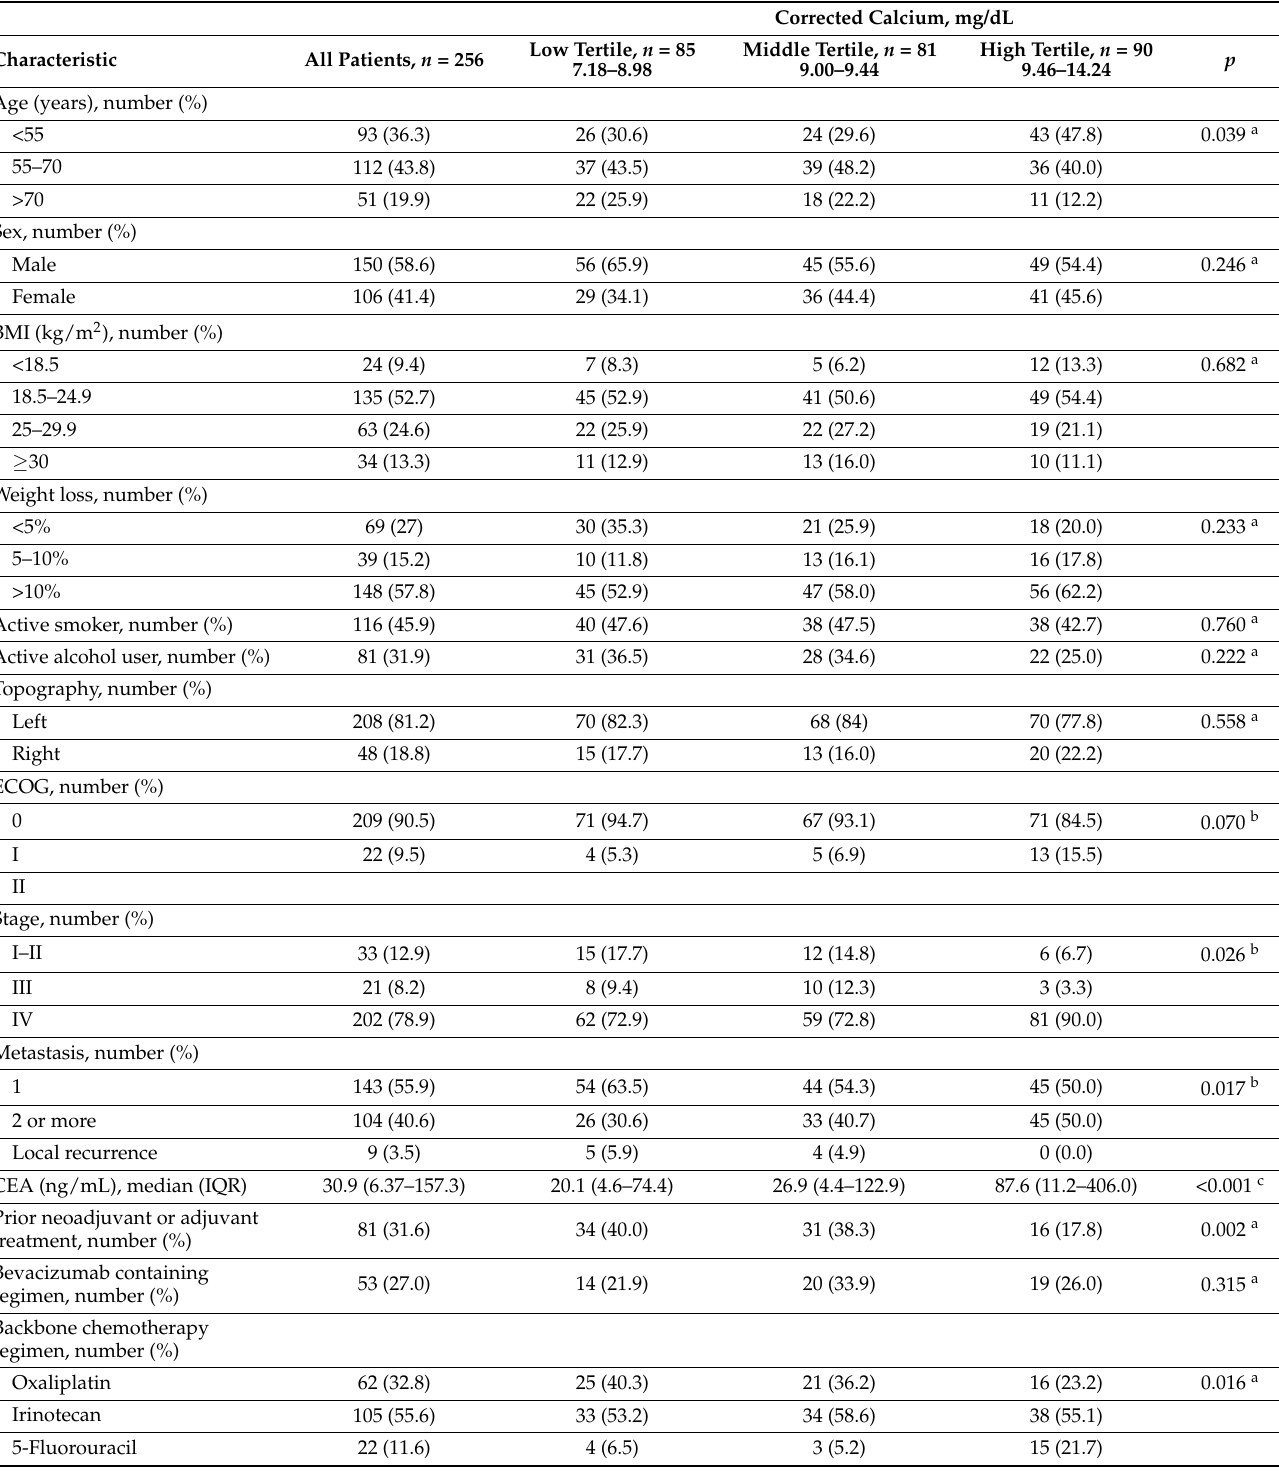
Table 1. Selected demographic and clinical characteristics and laboratory findings according to calcium tertiles of patients with metastatic colorectal